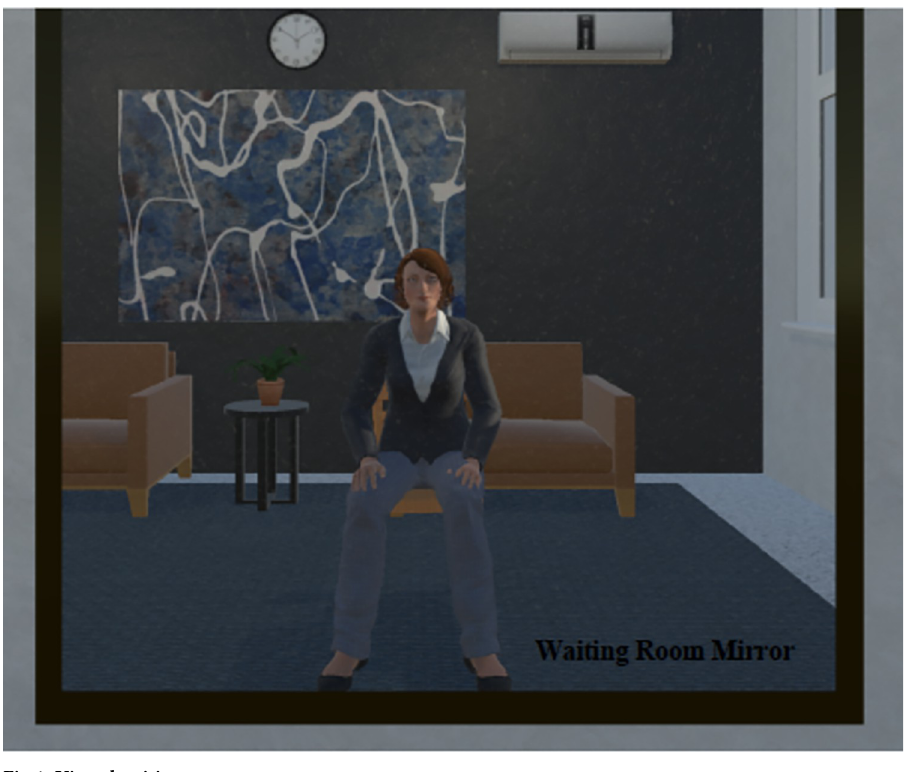
Fig 4. Virtual waiting room